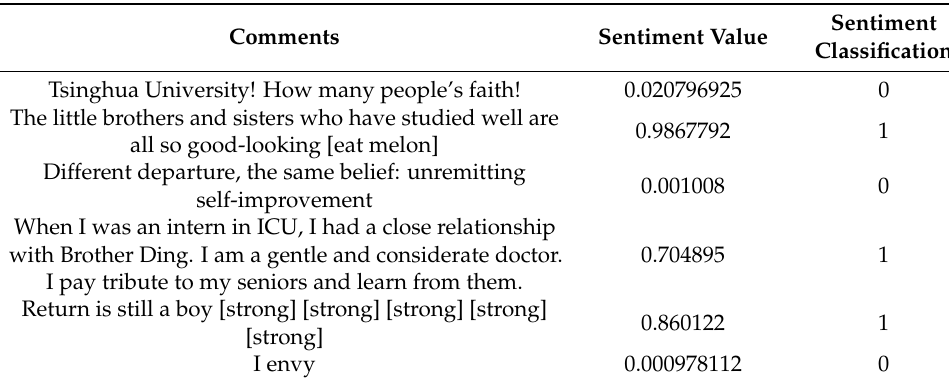
Table 2. BiLSTM_LSTM model prediction results.